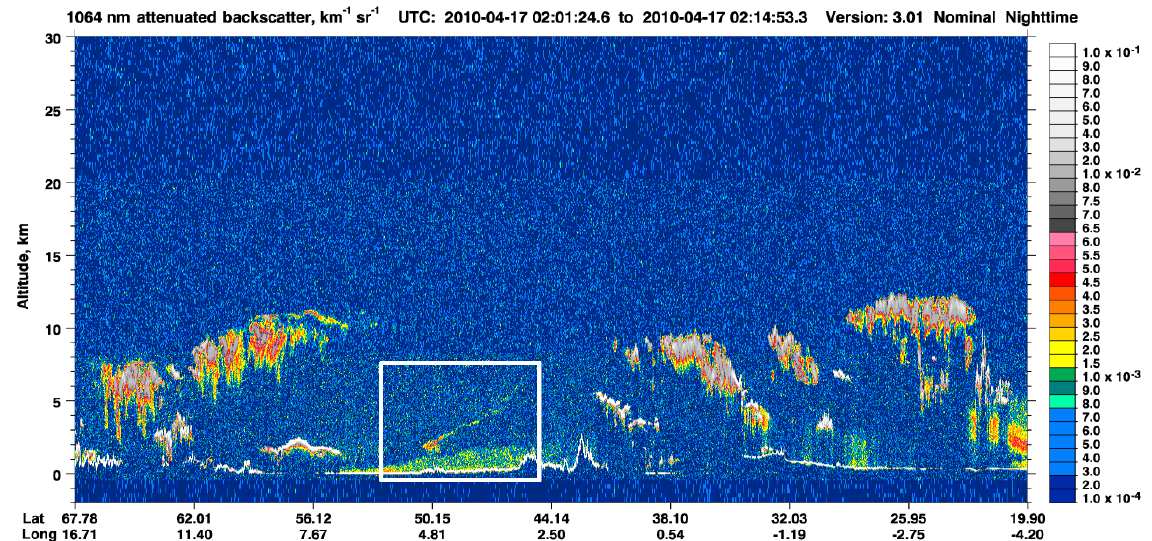
Figure 2. Attenuated backscatter coefficient measurement from CALIOP used to calibrate the ACL measurement during the Eyjafjallajökull eruption phase. The volcanic ash plume is visible around 50.15 ◦ , 4.81 ◦ . As the instrument measures from space, the values of the attenuated backscatter coefficient inside the ash plume is not affected by attenuation due to aerosols in the planetary boundary layer. Image obtained from http://www-calipso.larc.nasa.gov/.